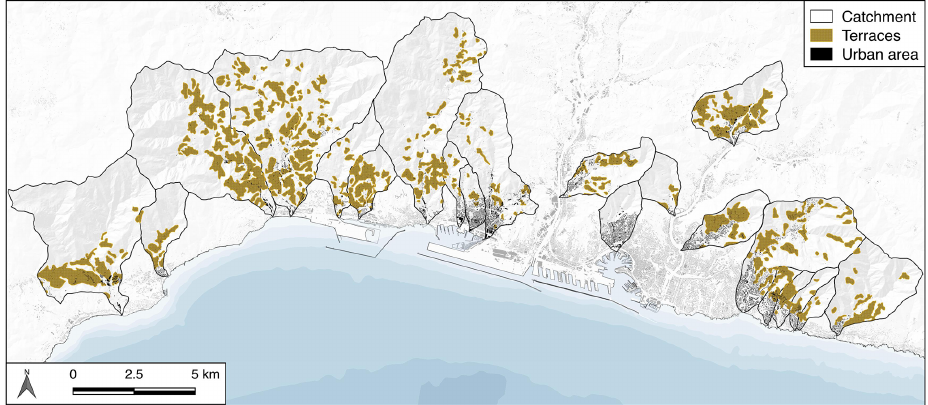
Figure 6. Artificial terraces in the studied